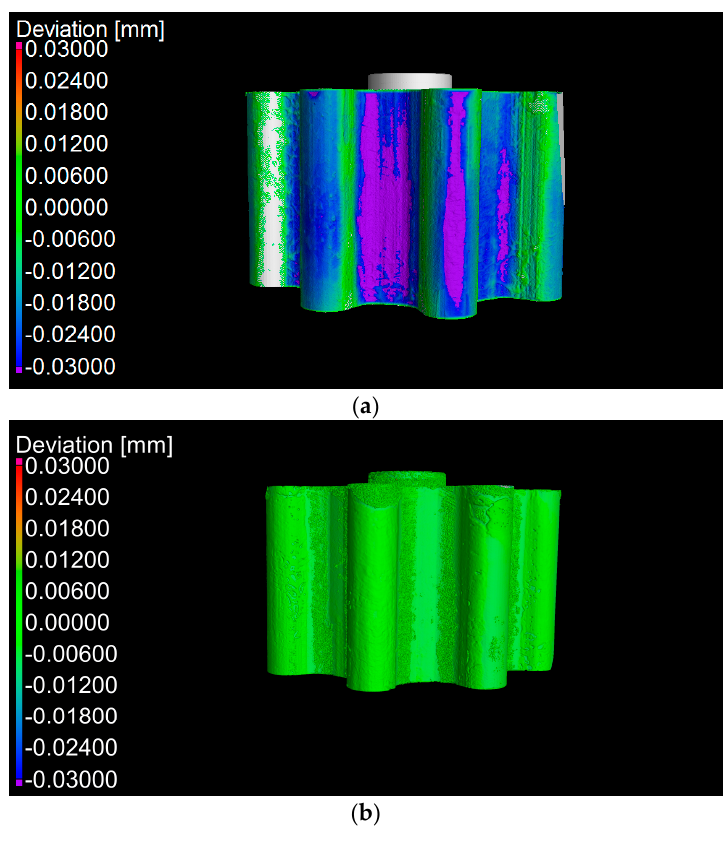
Figure 10. Actual-to-nominal comparison for ( a ) NPSG and ( b ) PSG. Deviation range ±0.03 mm.